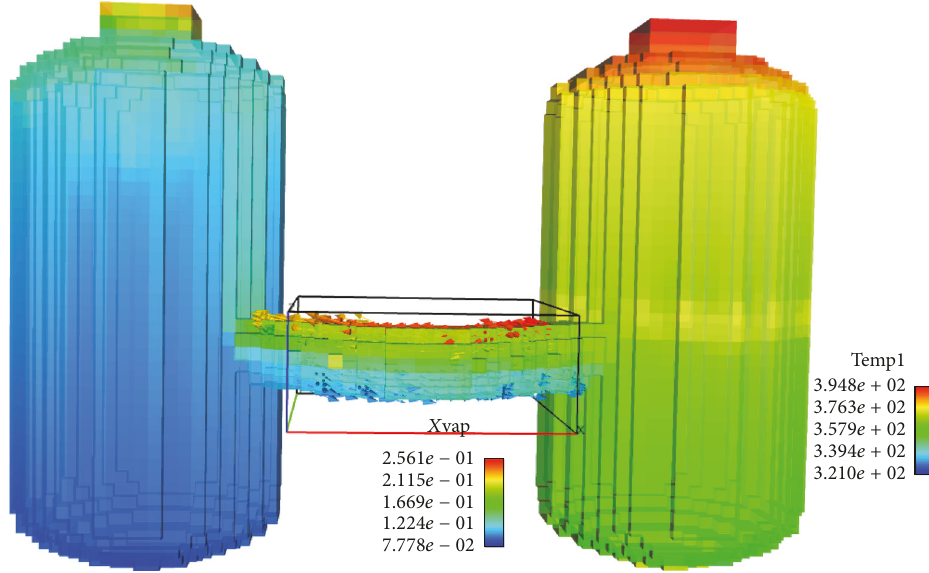
Figure 26: Gas temperature in ST3 2 at 𝑡 = 4000 s; vapor concentration is projected onto gas velocity in the IP.